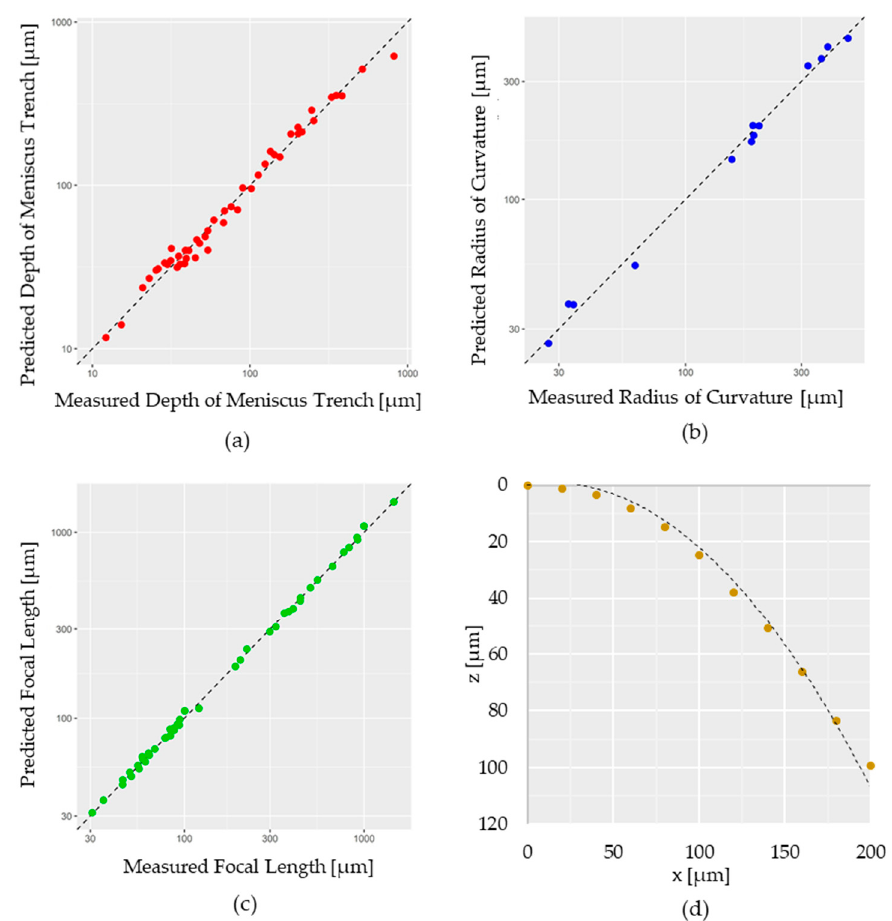
Figure 4. Scatter plots comparing the measured data against the predicted data using the modeling equations. The color dots represent the measured data, and the dashed line represents the predicted data: ( a ) the depth of meniscus trench; ( b ) the radius of curvature; ( c ) focal length; ( d ) surface profile.